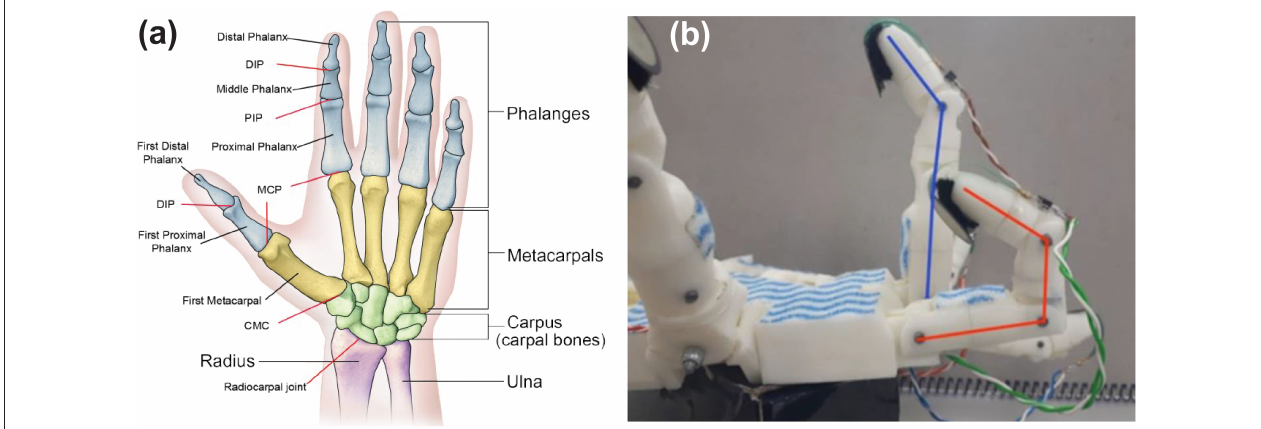
FIGURE 4 | (a) Diagram showing joints of the fingers (Reprinted with permission from Wheatland et al., 2015), (b) 3D printed InMoov robotic hand showing varying finger movements, and the FSR sensors mounted on the fingers.